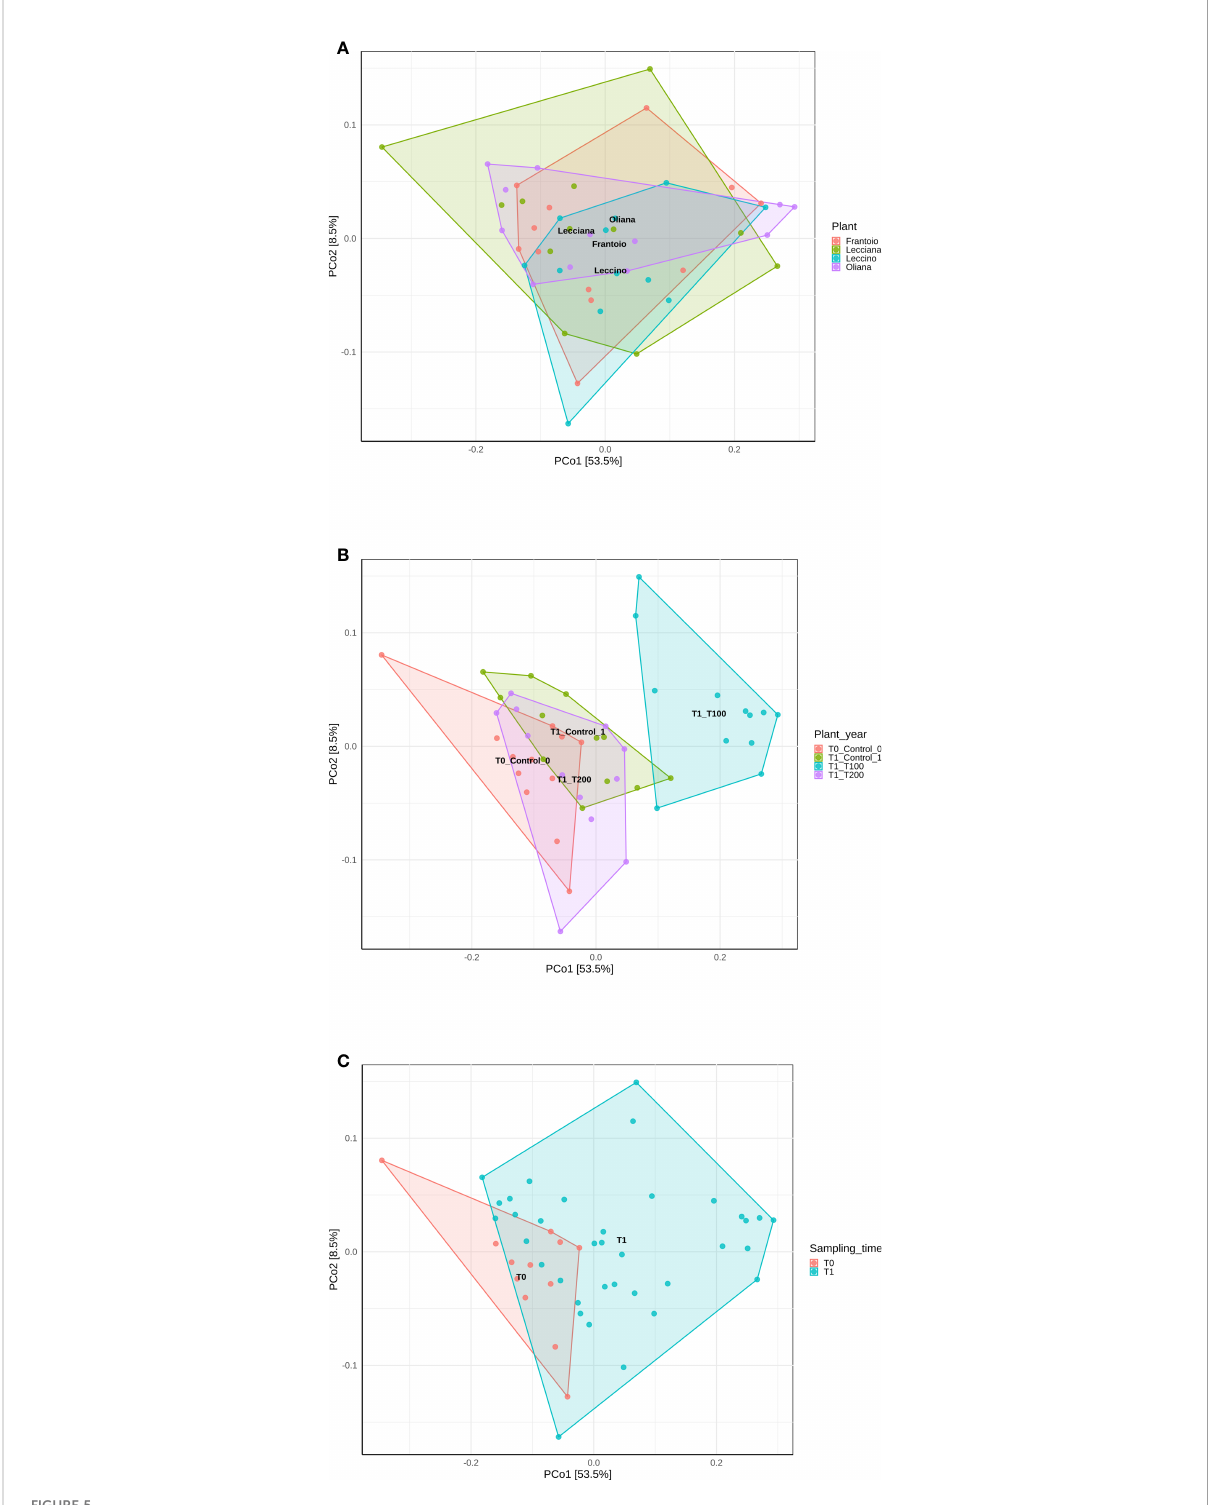
FIGURE 5 PCoA analyses of samples based on different variables using Bray-Curtis distance. Data were computed using the r package ampvis2, considering (A) cultivar, (B) treatment, and (C) sampling time. Total variance explained by each of the PCs is 62% (58.5% PC1, 8.5%